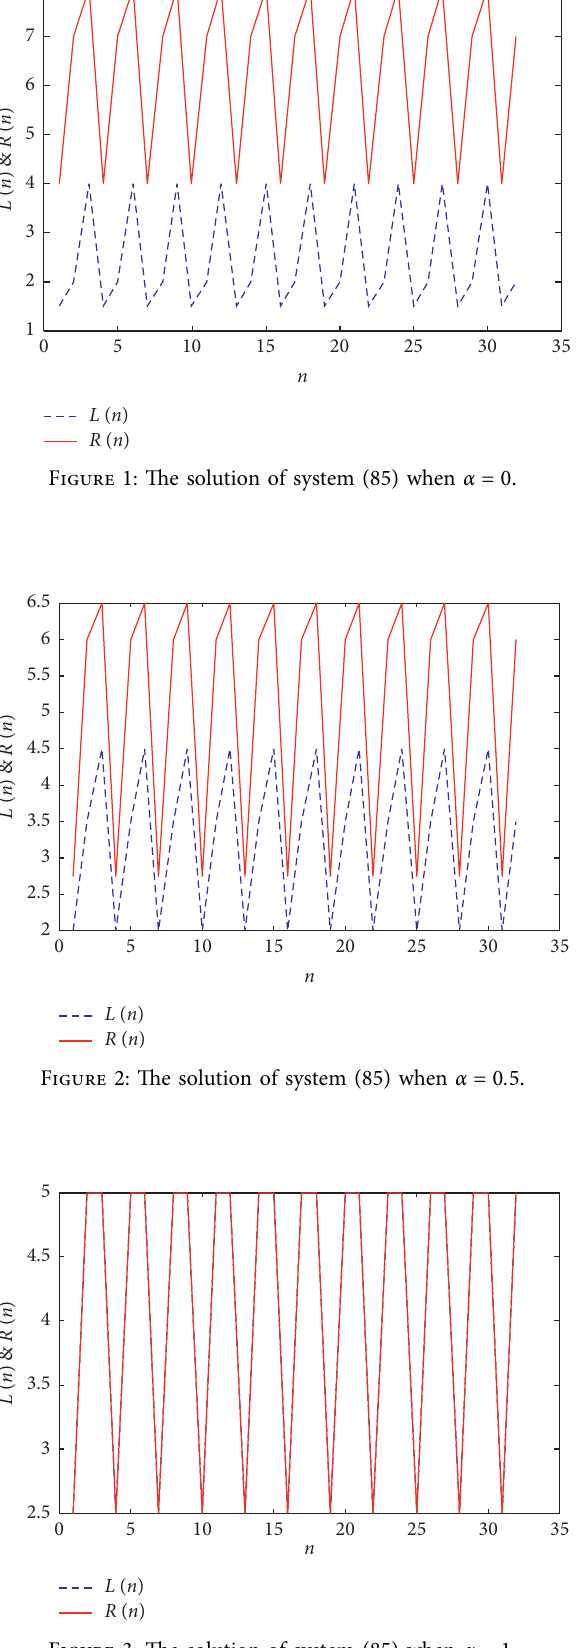
Figure 3: The solution of system (85) when α �